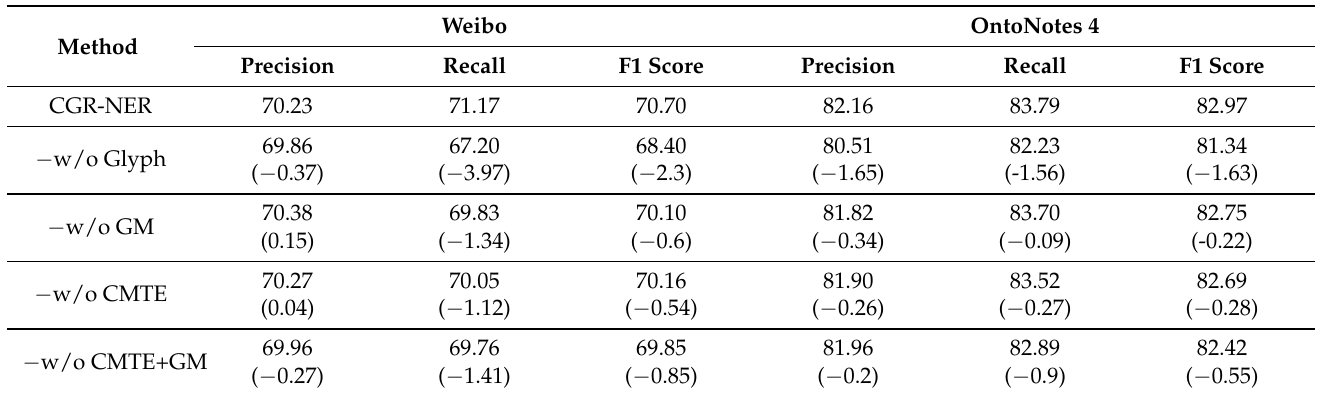
Table 9. Ablation experiment results on Weibo and OntoNotes 4 datasets.